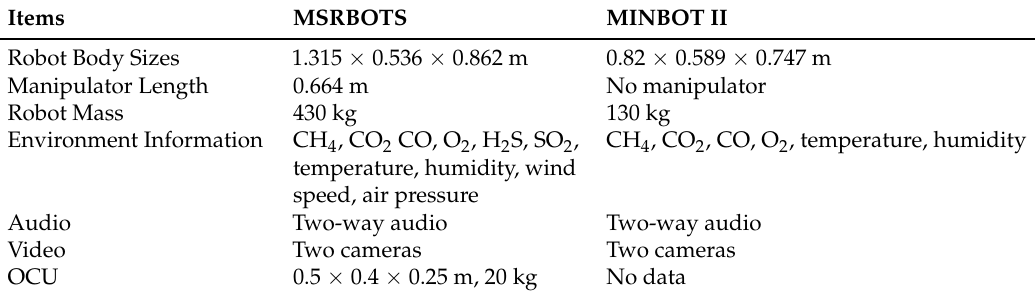
Table 1. The general structure of the parameters of the robot.